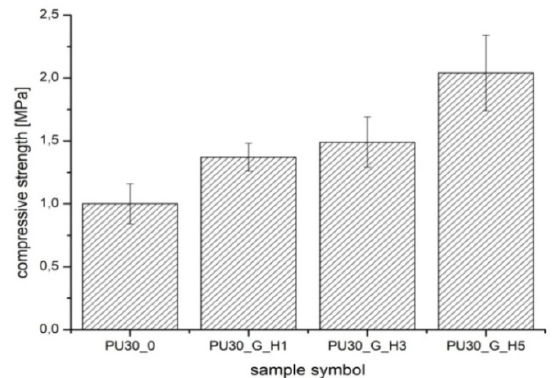
Figure 2. The compressive strength of PUR scaffolds.